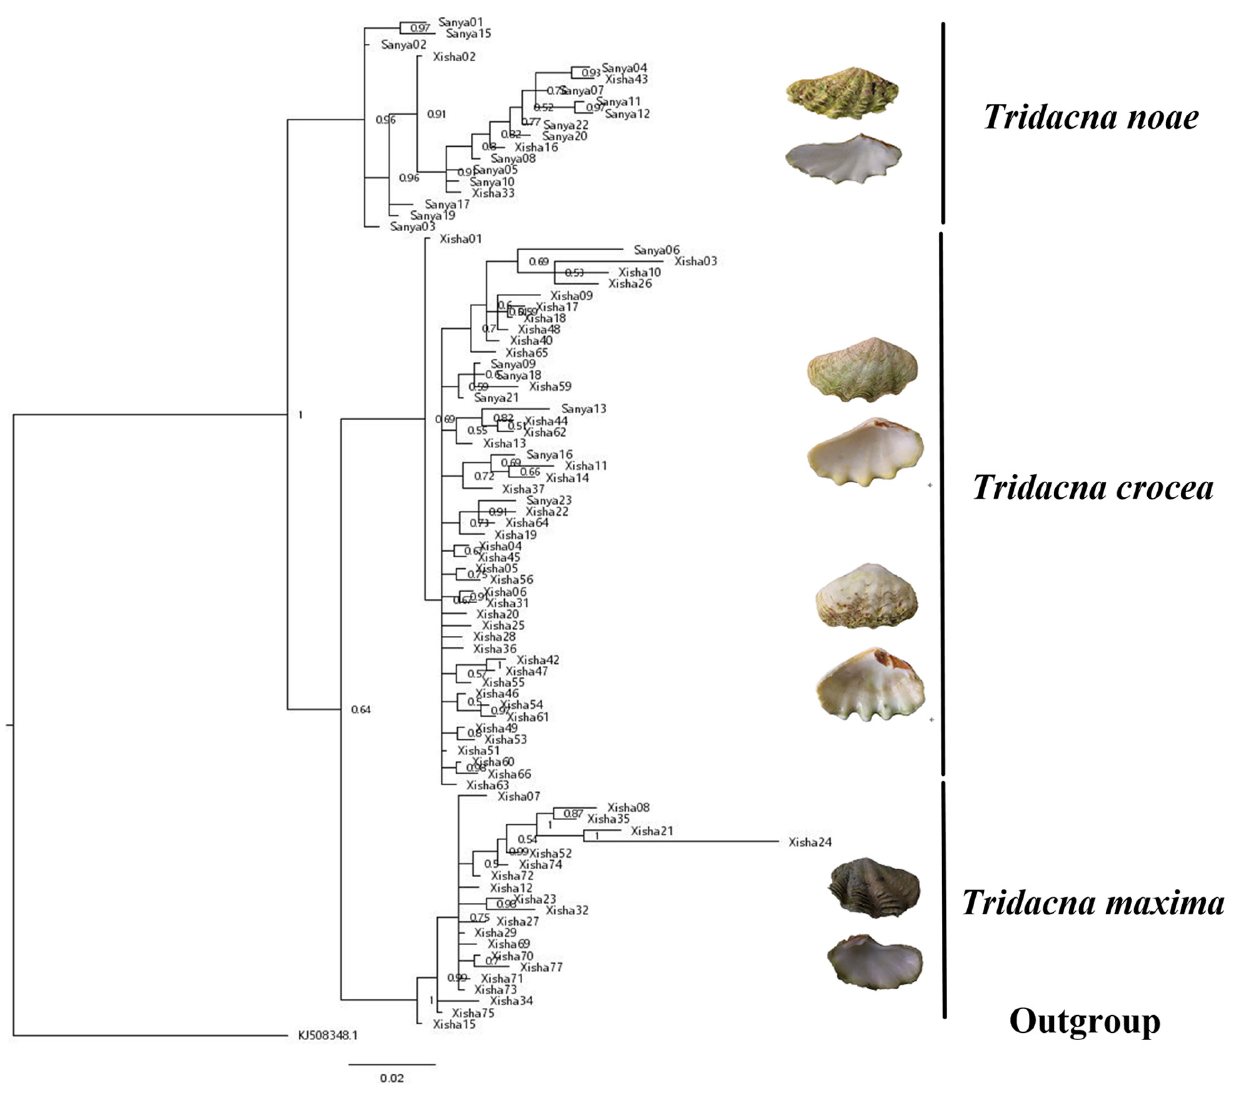
FIGURE 2 | BI tree of three giant clams based on 16S fragment. Hippopus hippopus (KJ508348) was used as outgroup. Numbers at nodes are posterior probabilities.